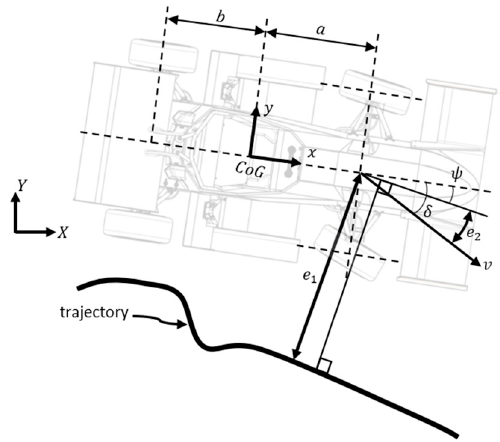
Figure 4. Definition of the controlled variables 𝑒 (cid:2869) and 𝑒 (cid:2870) with respect to the reference trajectory.